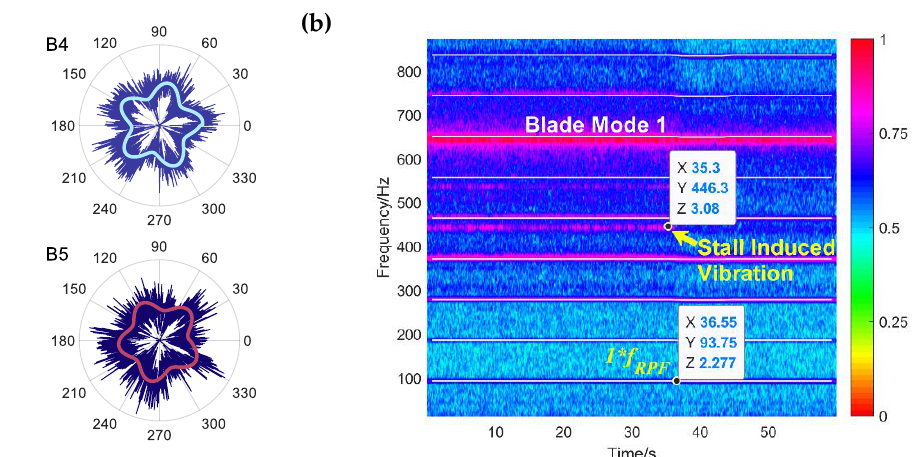
Figure 11. Rotating stall induced impeller blade vibration: ( a ) 5 stall cells dominated aerodynamic exciting force in polar coordinate and ( b ) time-frequency analysis of Strain Gauge G3.